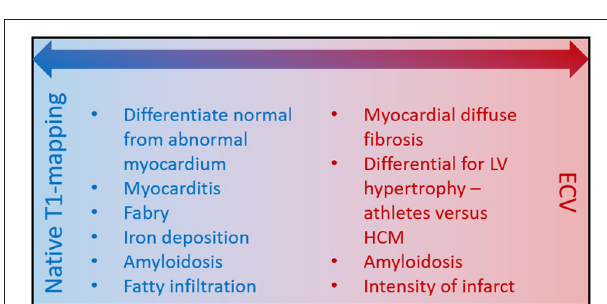
FIGURE 4 | Diagnostic complementary utility of native T1-mapping vs. ECV. The main advantage of ECV is that it takes gadolinium flow kinetics into consideration to improve the precision of